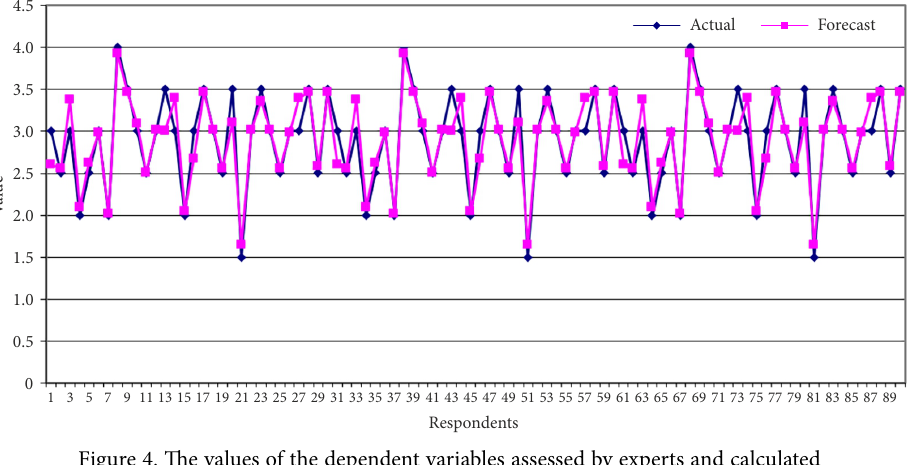
[3.06]Figure 4. The values of the dependent variables assessed by experts and calculated by Model Y for CRO (source: calculated by authors)